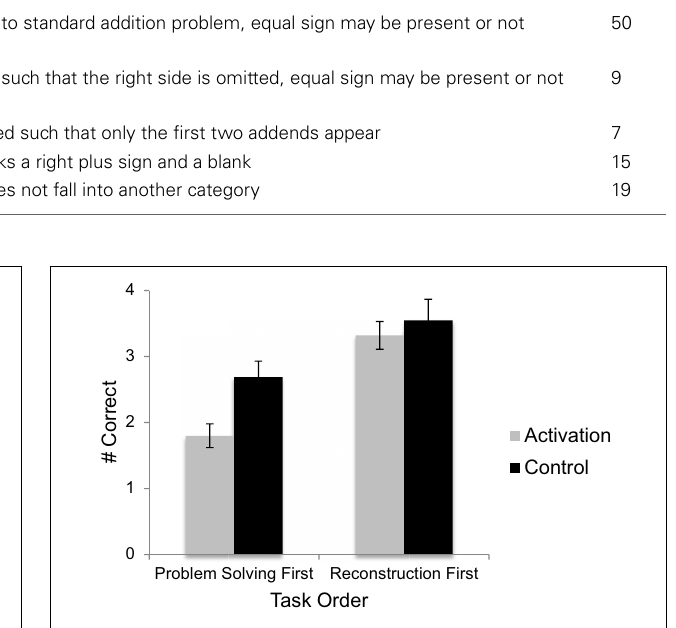
Table 3 | Examples of conceptual errors in reconstructing the equivalence problem 3 + 4 + 5 = __ + 5. Reconstruction